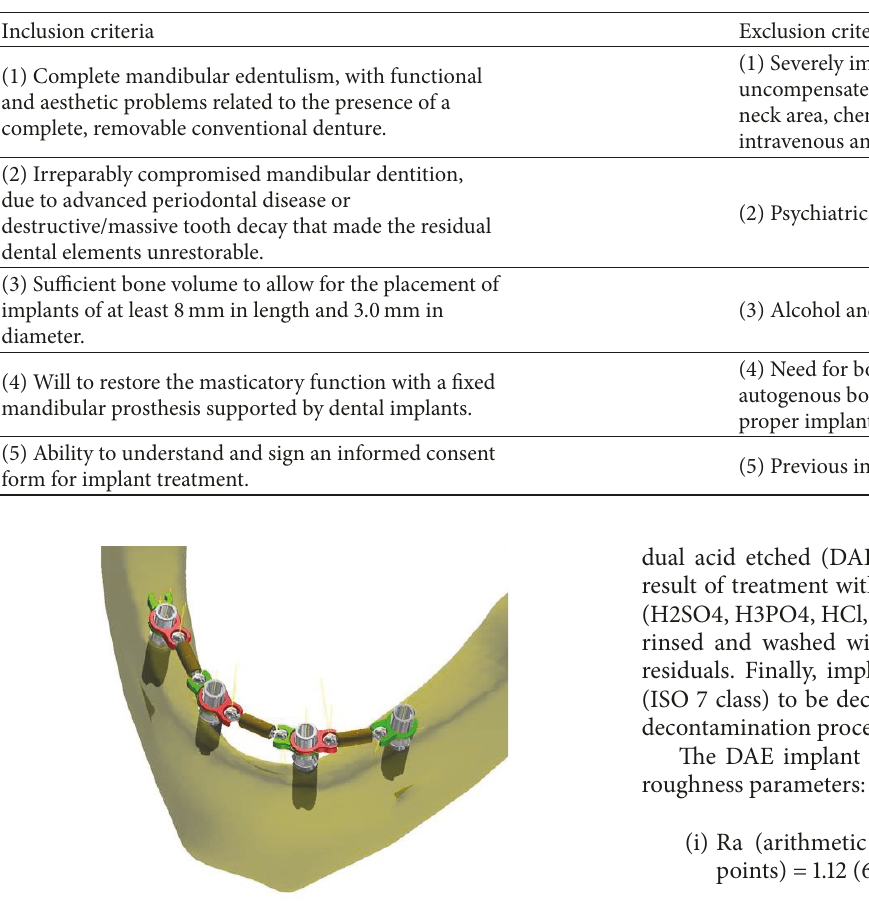
Table 1: Inclusion and exclusion criteria for enrollment of patients in the study.